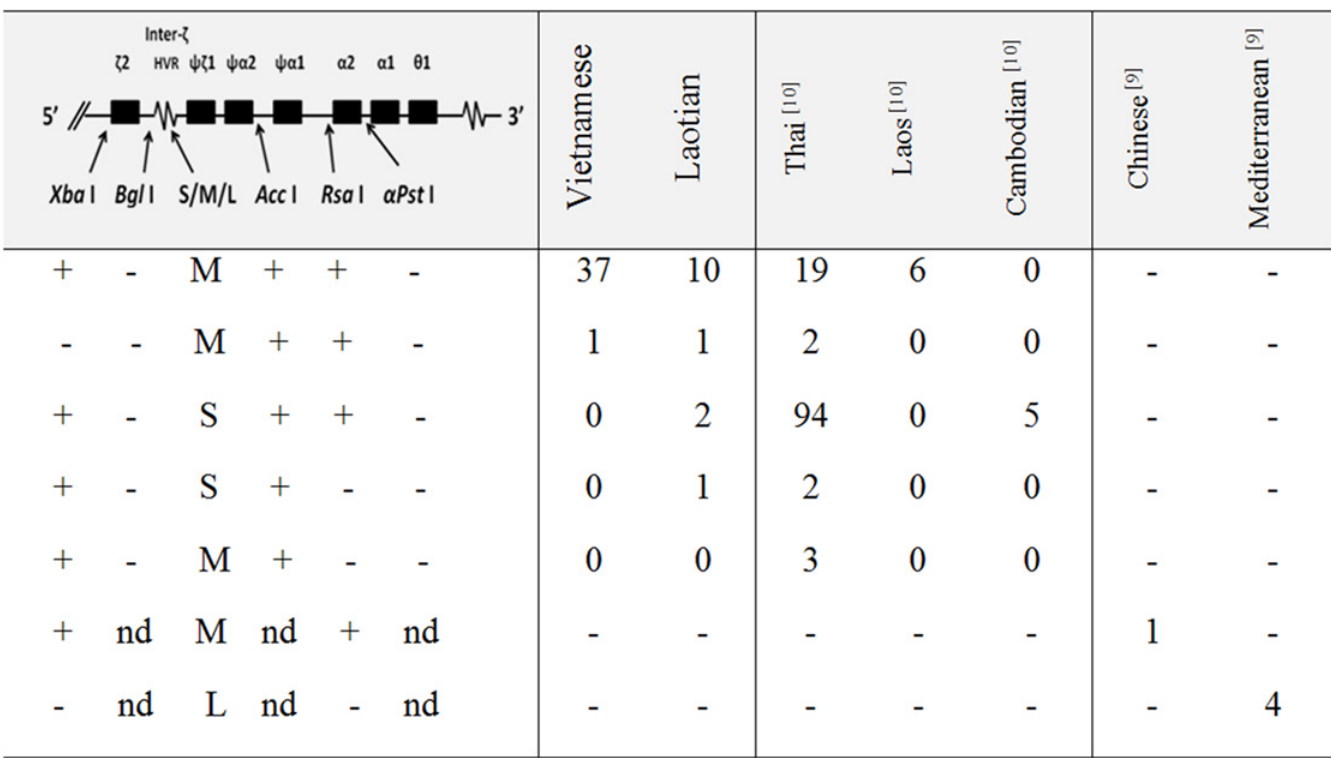
Fig 1. α -Globin gene haplotypes associated with Hb CS genes in Vietnamese and Lao subjects as compared to those described in other populations. Number of alleles detected in each haplotype is indicated. Plus and minus indicate the presence and absence of each polymorphic site. nd: not